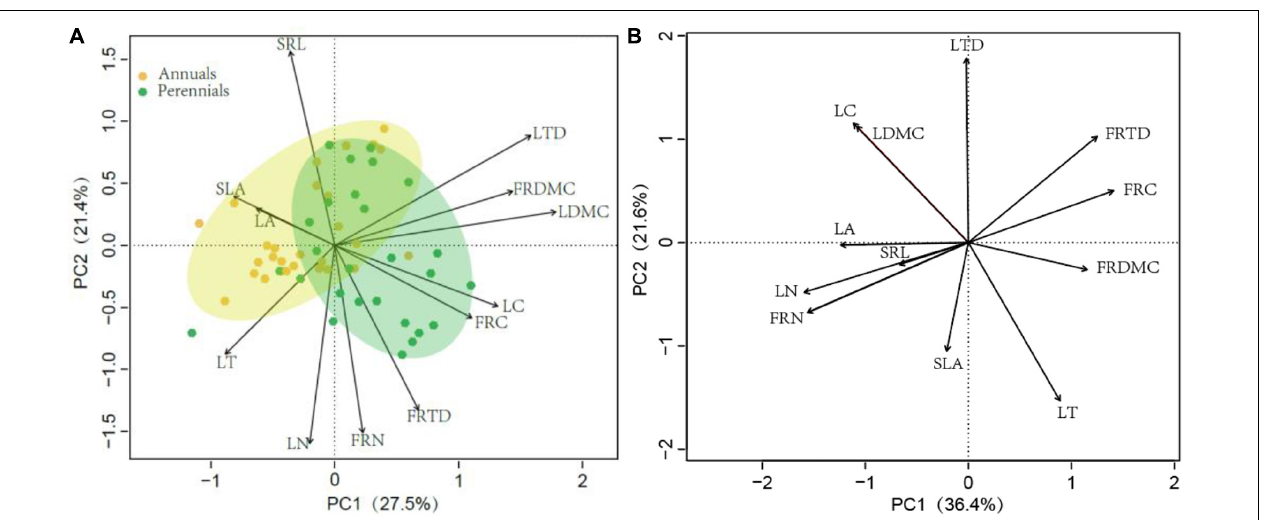
the LT, LDMC, and LC were loaded on the PCA axis 2 ( Supplementary Table A. 3